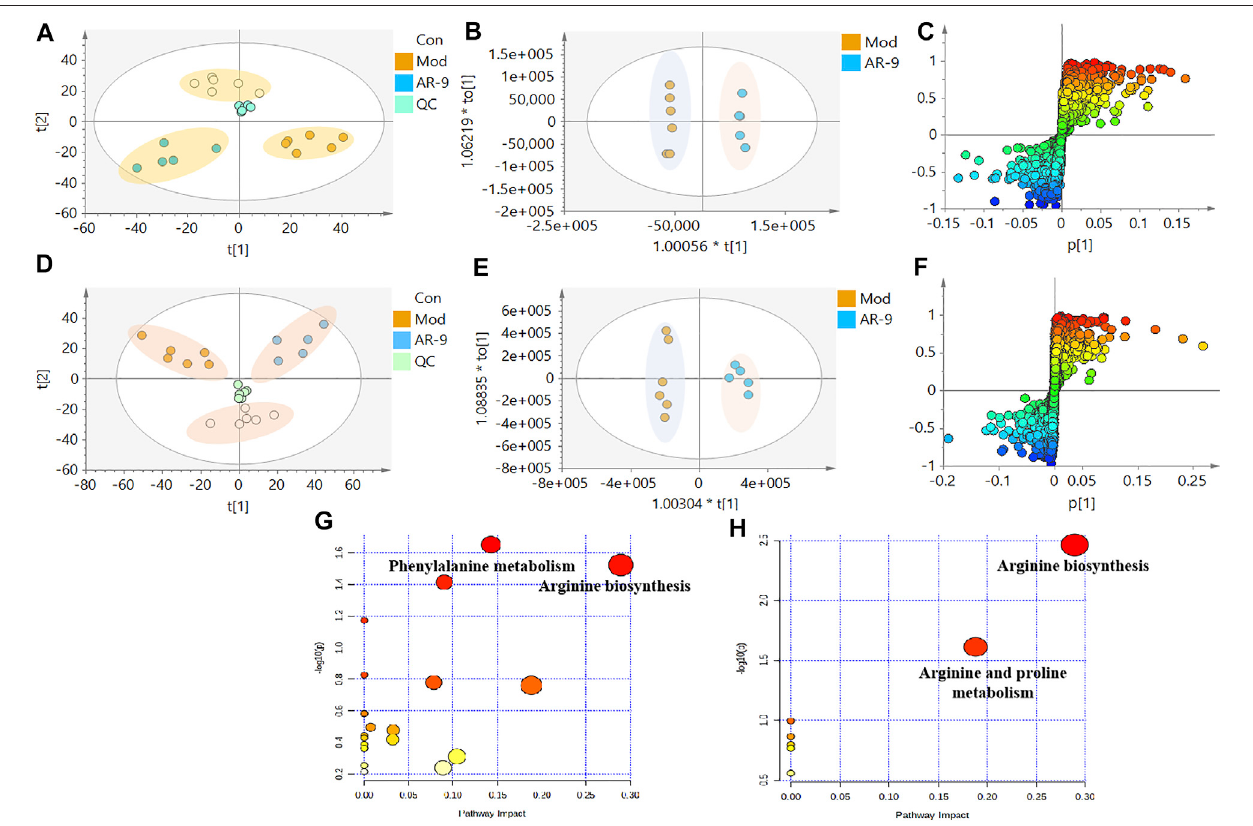
FIGURE 3 | Effects of AR-9 on metabolic parameters in HL rats and correlation analysis. (A) Negative PCA score plot. (D) Positive PCA score plot. (B) Negative OPLS-DAplots( R2X =0.315, R2Y =0.997, Q2 =0.756, p -valueofCV-ANOVA=0.0473). (E) PositiveOPLS-DAplots( R2X =0.433, R2Y =0.979, Q2 =0.795, p -valueof CV-ANOVA=0.0293). (C) NegativeS-plots. (F) Positive S-plots. (G) Fecal samplepathway analysisbetweenCon vs.Mod. (H) Fecalsamplepathway analysisbetween AR-9 vs.